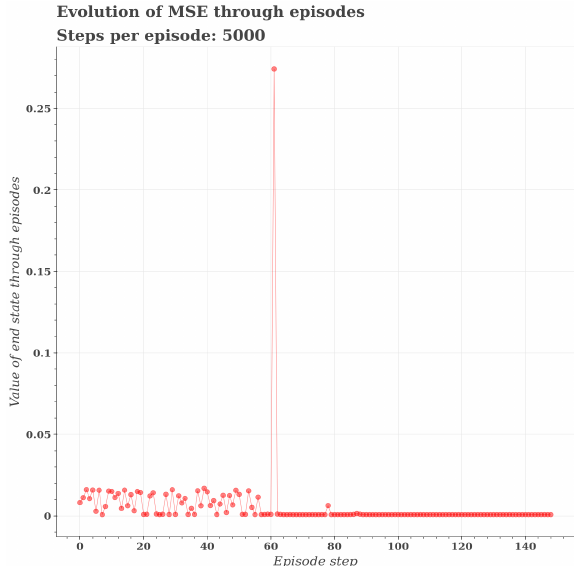
Figure 10. MSE between original data and estimated solution at the end of each of the 150 episodes for the averaging function. After the exploration phase, the MSE converges to 0. The search for the appropriate parameter for the conjunctive function follows the same pattern. After the exploration phase, the agent finds the solution near 1.2 at the end of each episode, as seen in Figures 11 and 12.